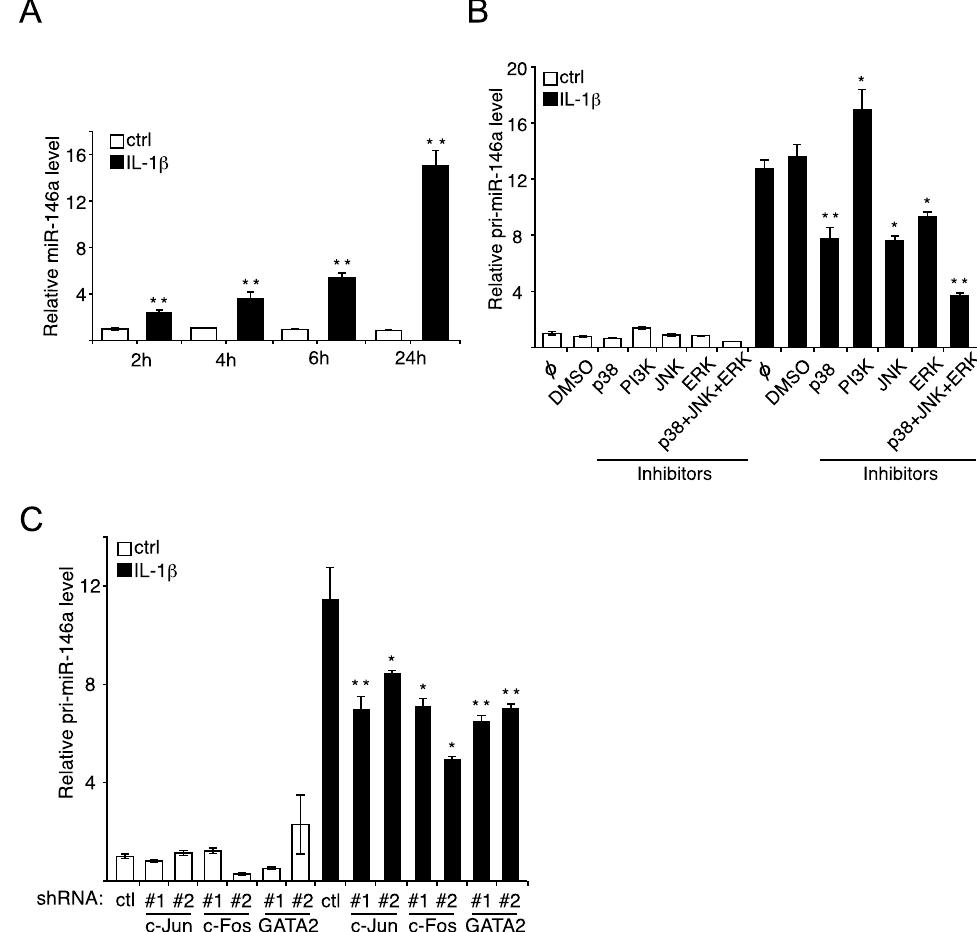
Figure 5. IL-1 β induces the transcription of miR-146a via p38, JNK and ERK pathways. ( A ) Endothelial cells were treated with IL-1 β (20ng/ml). The miR-146a level was measured by RT-qPCR and the snRNA U6 was used as the normalization control. The p -values are calculated comparing to the ctrl at each time point. ( B ) Endothelial cells were pre-treated with 10 μ M of p38 inhibitor SB203580, 10 μ M of JNK inhibitor SP600125, 10 μ M of ERK inhibitor PD098059, or/and 10 μ M of PI3K inhibitor LY294002 for 1 hour before the addition of IL-1 β (20 ng/ml). Pri-miR-146a level was measured relative to GAPDH mRNA using RT-qPCR. The p -values are calculated comparing to the “DMSO/IL-1 β ” group. ( C ). Upon knockdown with lentivirus expressing either control (scramble shRNA) or two different shRNAs targeting each transcription factor (c-Jun, c-Fos and GATA2), pri-miR146a levels relative to GAPDH mRNA (control) were determined by RT-qPCR. The p -values are calculated comparing to the “shRNA ctrl/IL-1 β ” group. The quantification are the mean values of three independent experiments, the error bars represent standard errors of three independent experiments, and the significance was analyzed using a Student’s t-test ( * p < 0.05; ** p <